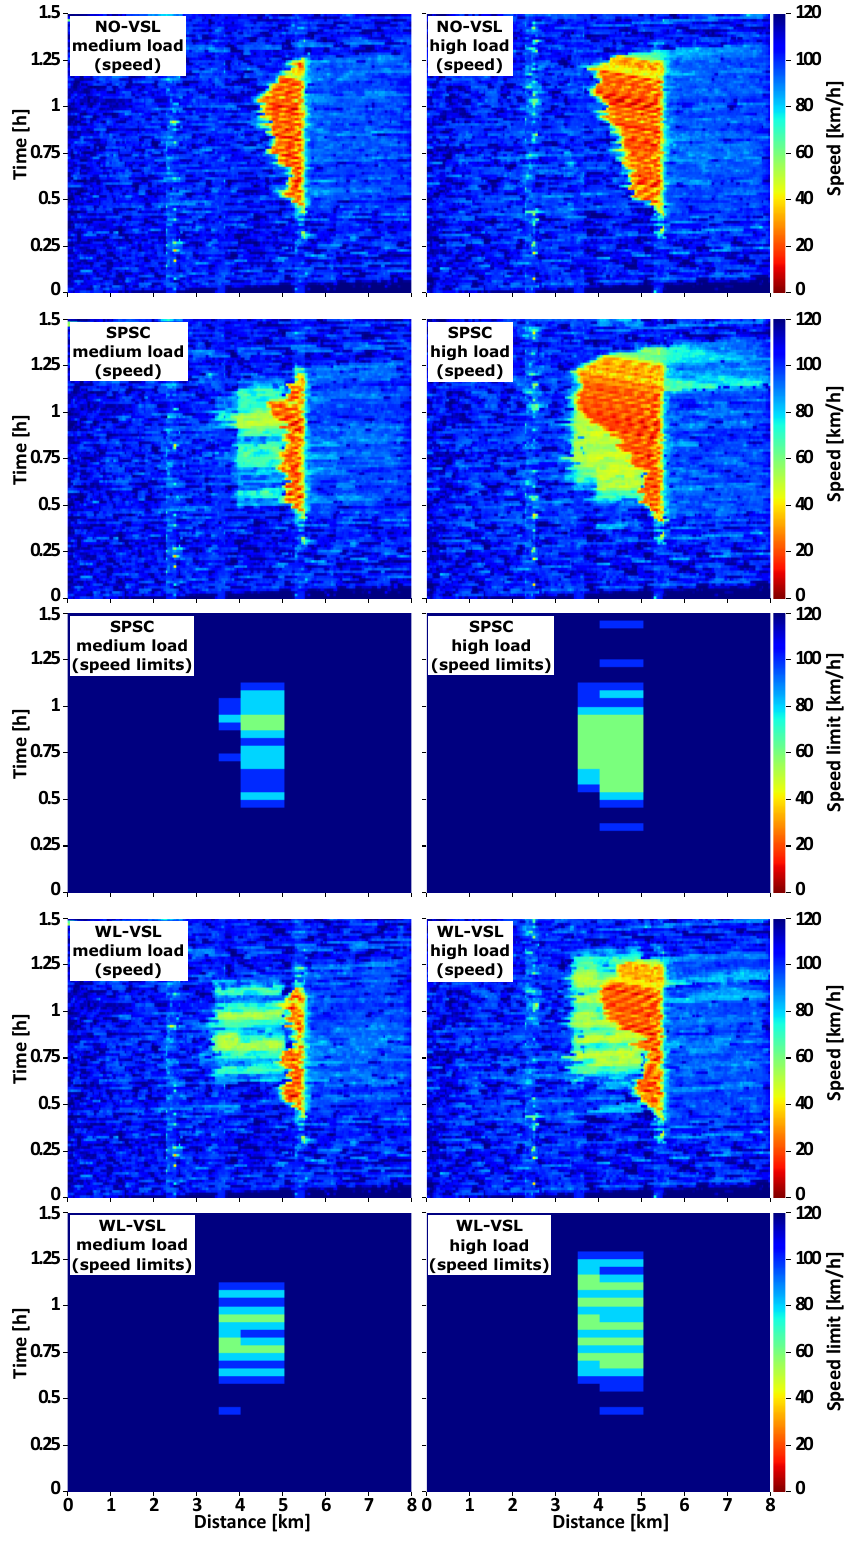
Figure 4. Space-time diagrams for simulated scenarios with static VSL